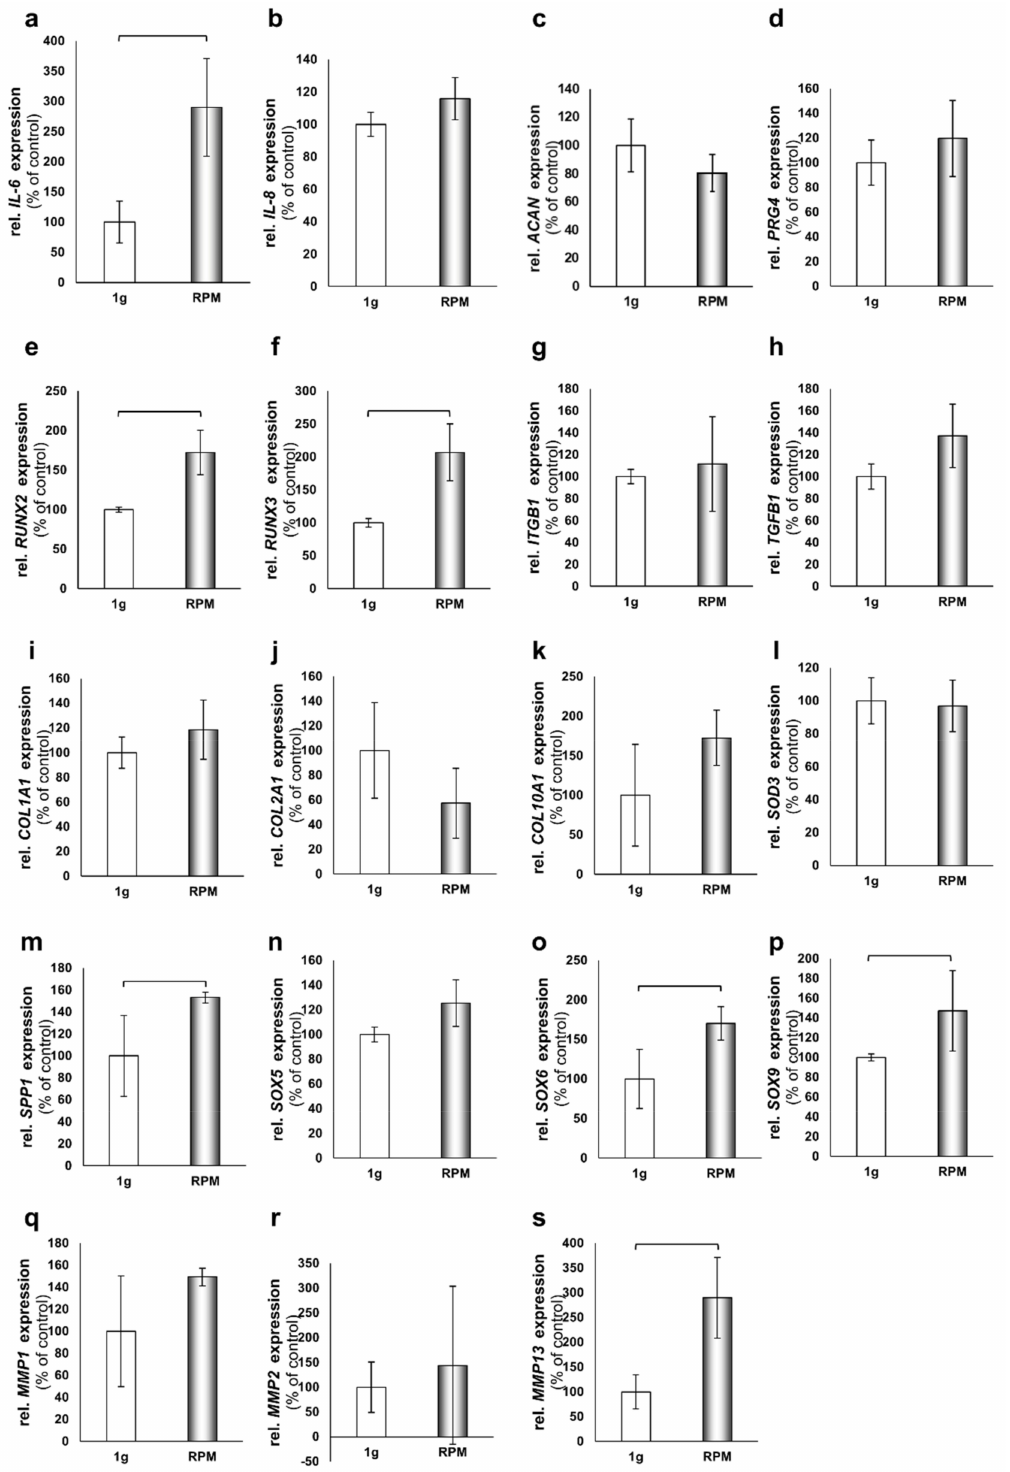
Figure 3. Quantitative real-time PCR analysis of cartilage-related genes. ( a ) IL6. ( b ) CXCL8 (IL8). ( c ) ACAN. ( d ) PRG4. ( e ) RUNX2. ( f ) RUNX3. ( g ) ITGB1. ( h ) TGFB1. ( i ) COL1A1. ( j ) COL2A1. ( k ) COL10A1. ( l ) SOD3. ( m ) SPP1. ( n ) SOX5. ( o ) SOX6. ( p ) SOX9. ( q ) MMP1. ( r ) MMP2. ( s ) MMP13. All analyses were done with chondrocytes cultivated in DMEM / F-12 medium for 24 h on the RPM. Static samples incubated beside the RPM inside the same incubator served as the 1 g controls. Brackets above the bars indicate significant changes ( n = 5 each group: 1 g and RPM), significance p <